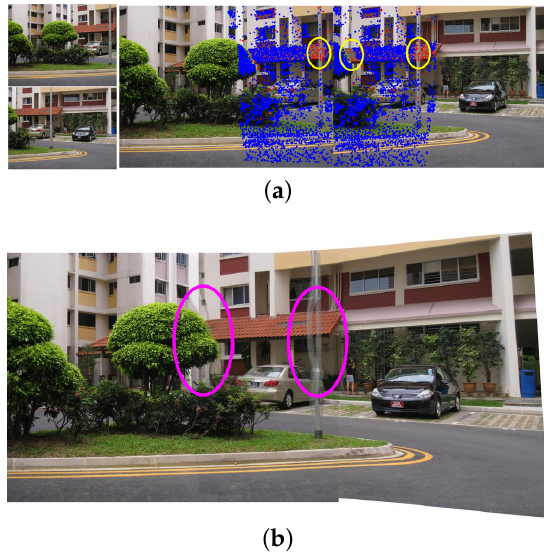
Figure 10. A failure case using our method. ( a ) Occlusions will cause the lack of feature points. ( b ) The artifacts are circled in the stitched